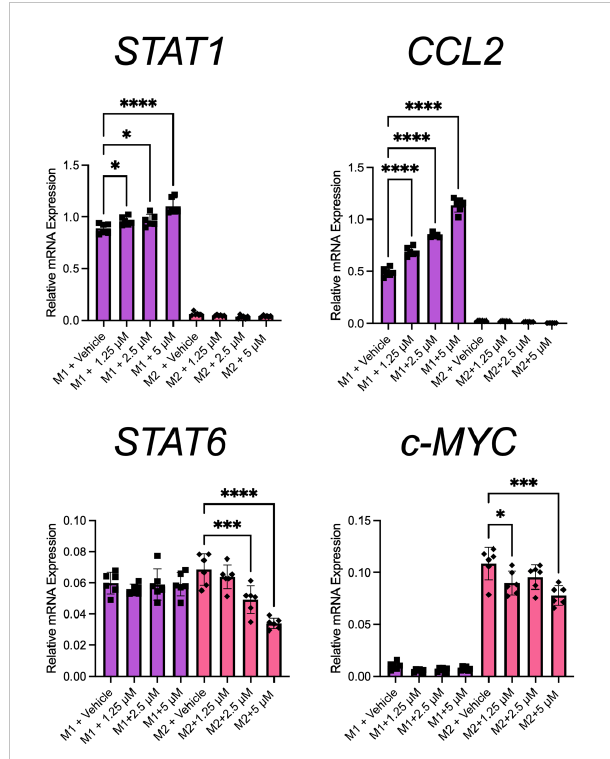
FIGURE 3 PHX promotes M1 macrophage transcriptional programming. THP-1 derived M1 or M2 macrophages were treated with PHX during their differentiation stage and qRT-PCR. mRNA expression of STAT1 , CCL2 , STAT6 and c-MYC in M1 (purple) and M2 (pink) macrophages. Data are pooled from 2 independent experiments with 3 replicates from each experiment and presented as mean ± SD of pooled replicates. One-way ANOVA with Dunnett's multiple comparisons test was performed for the analysis * p ≤ 0.05; *** p ≤ 0.001; **** p ≤